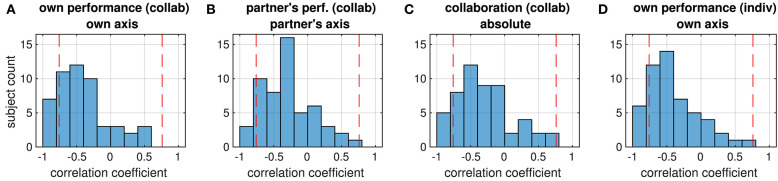
Distribution of correlation coefficients between ratings (given in the first line of the title) and objective performance (tracking error, second title line) of all subjects. Red dashed lines mark the strength beyond which correlations are significant (p < 0.05, FDR-corrected). Correlations are mostly negative because subjects were asked to rate higher performance, which corresponds to smaller tracking errors, by larger values. The four panels show the distribution of correlations between (A) own performance rating and tracking error on the own axis (collaborative condition), (B) the partner's performance rating and the tracking error on the partner's axis, (C) ratings of collaboration and the Euclidean tracking error, (D) own performance rating and tracking error on the own axis (individual condition).